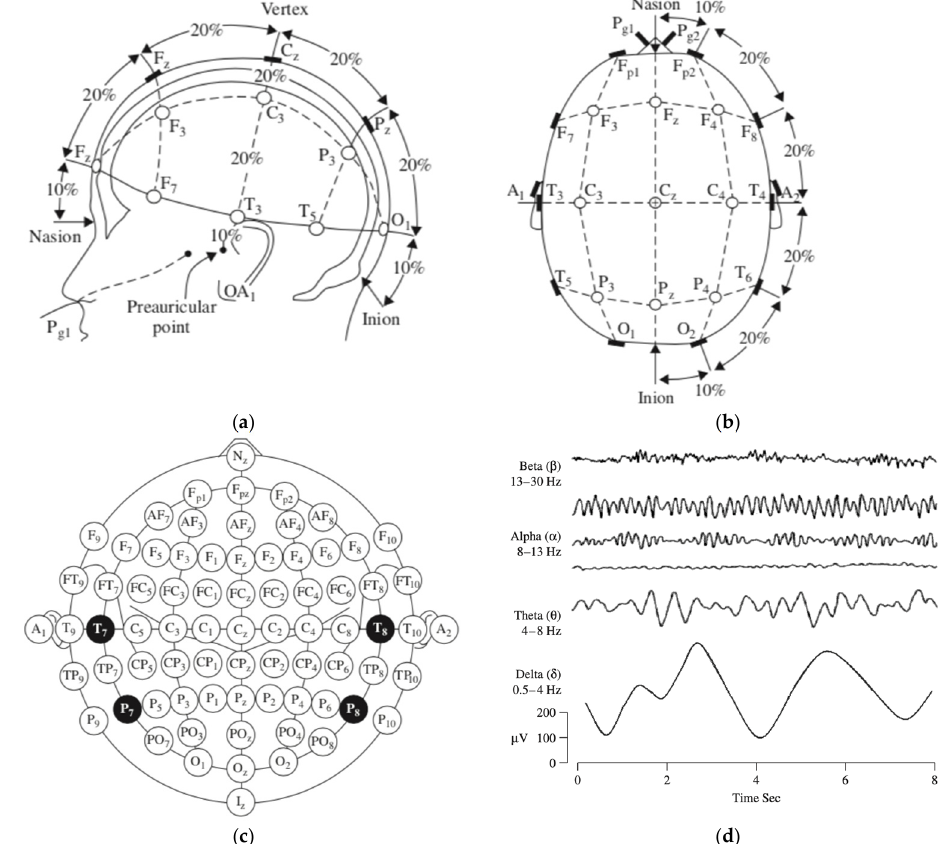
Figure 4. ( a ) and ( b ) represent the 2D view of the 10–20-electrode setup configuration for 21 elec- trodes. ( c ) Representation of 10–20 electrode locations (75 in total counting the reference electrodes) and ( d ) wave signals generated. Images obtained from [32].